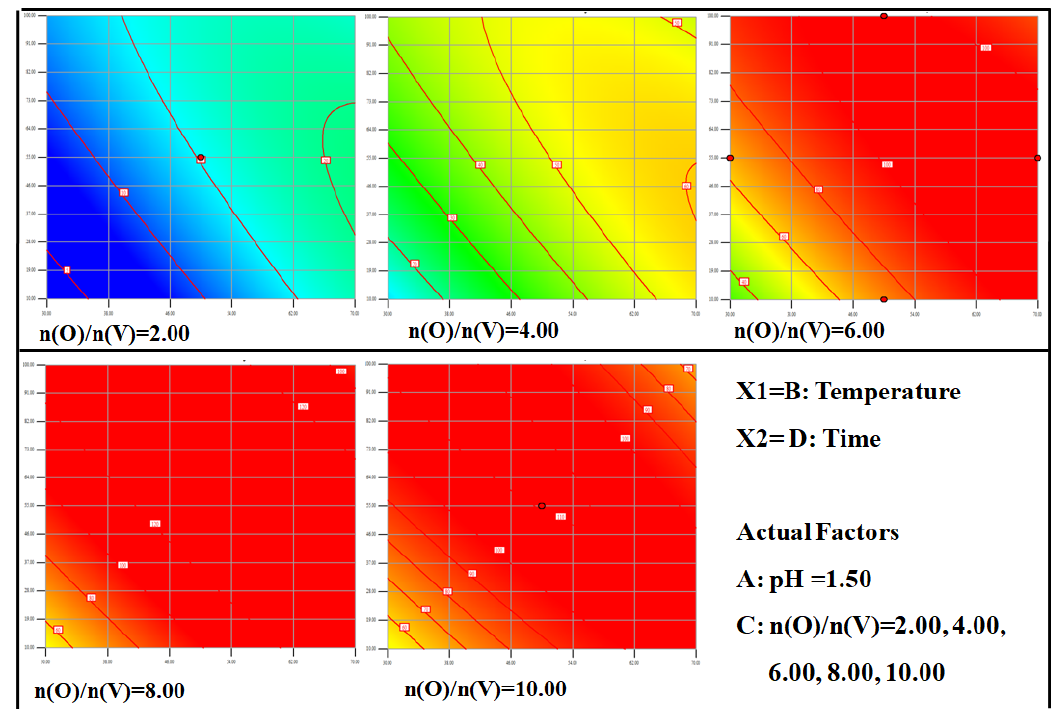
Figure 10. Response surface plots for factors (B to D).